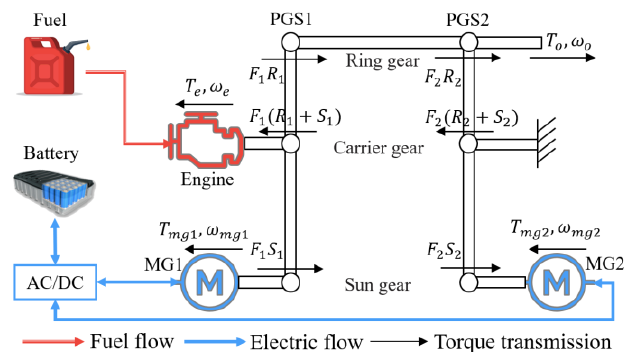
Figure 1. Lever diagram and power flow of the power-split HEV powertrain.